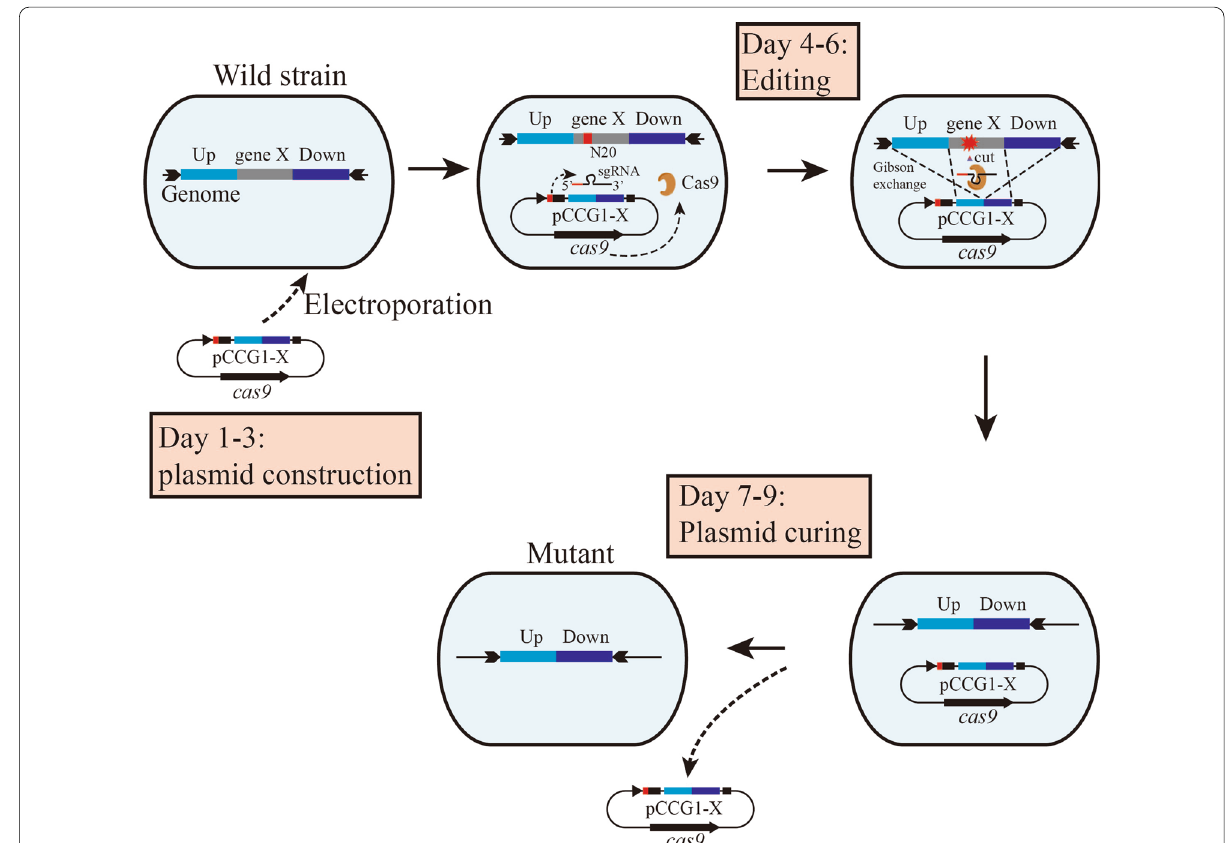
Fig. 4 The diagram of genomic editing procedure. a Day 1–3: The recombinant plasmid construction for targeted gene X in E. coli DH5α. Day 4–6, electroporate the plasmid into the electrocompetent cell of C. glutamicum and cultured for 2–3 days at 28 °C, examine the colonies using colony PCR method. N20 sequence at 5 ′ -end of sgRNA was complementary to the targeted gene X, which guide Cas9 to break genome at PAM (NGG) site, the upstream and downstream homologous sequence in plasmid was used to repair the DSBs. Day 7–9, cure the plasmids in positive cells. If continuous editing was needed, make electrocompetent cells of the positive cells, electroporate another plasmid into it for the next editing